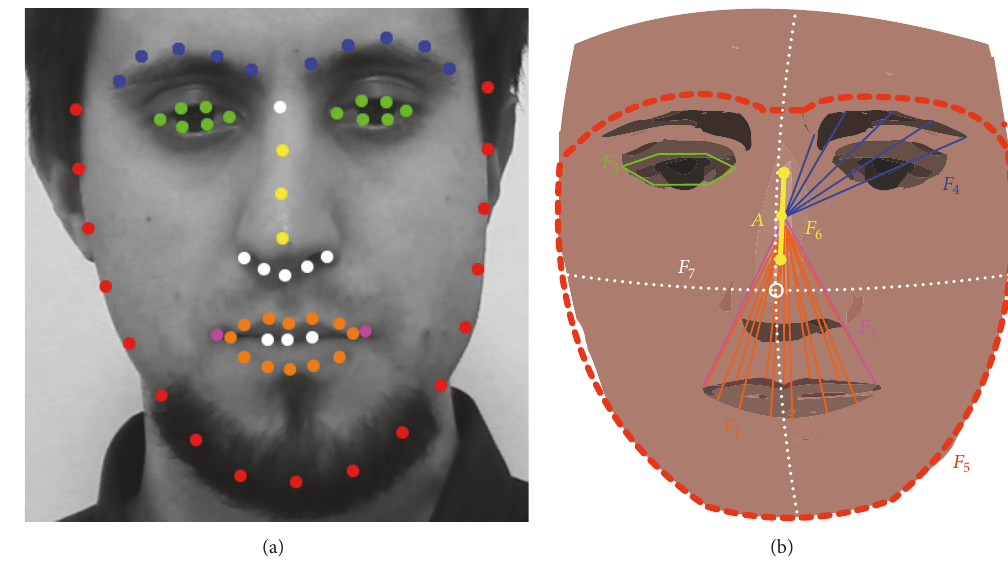
Figure 5: Facial landmarks and features. (a) Highlight of 68 detected facial landmarks. (b) Visual representation of our facial